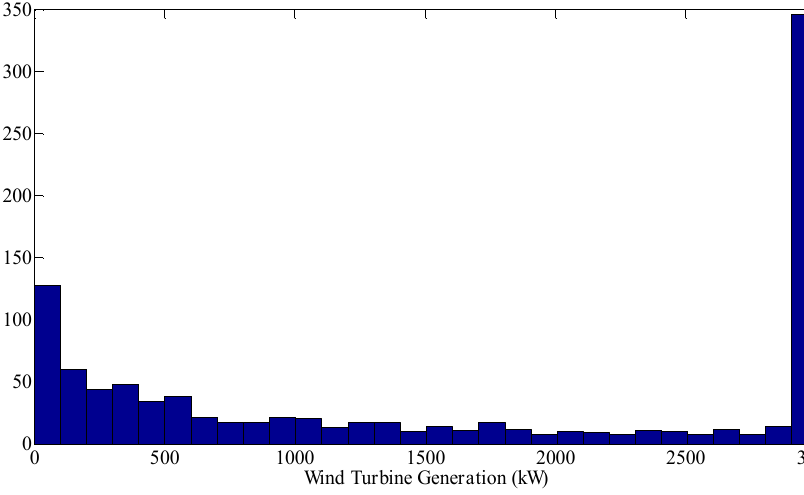
Figure 5. PDF of wind turbine power.